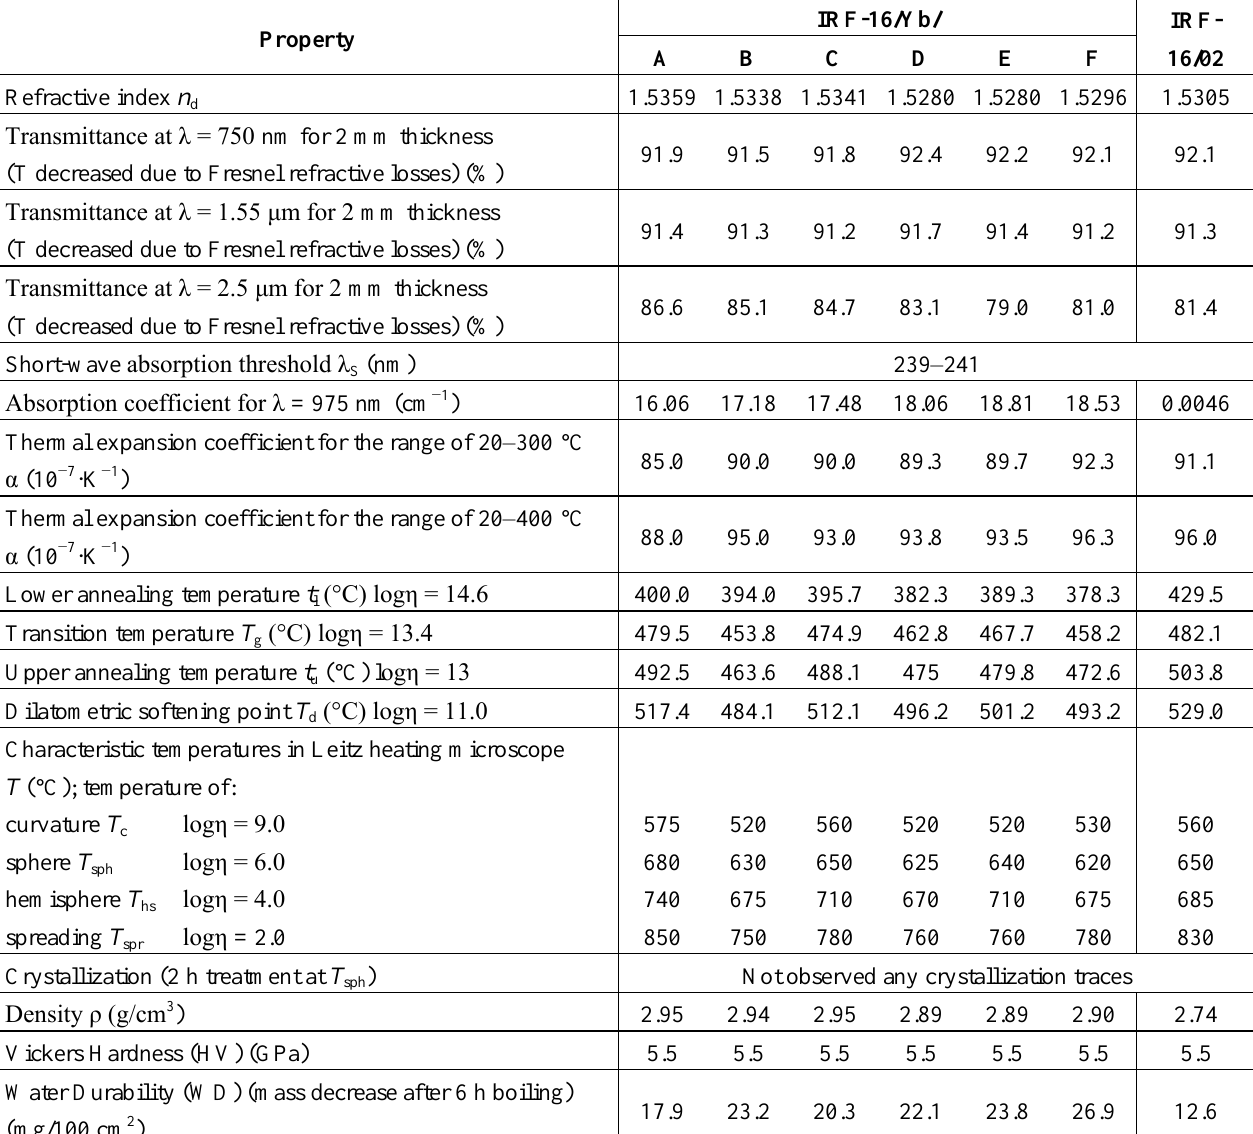
Table 1. Basic properties of the IRF-16/6Yb/A-F series glasses and IRF-16/02